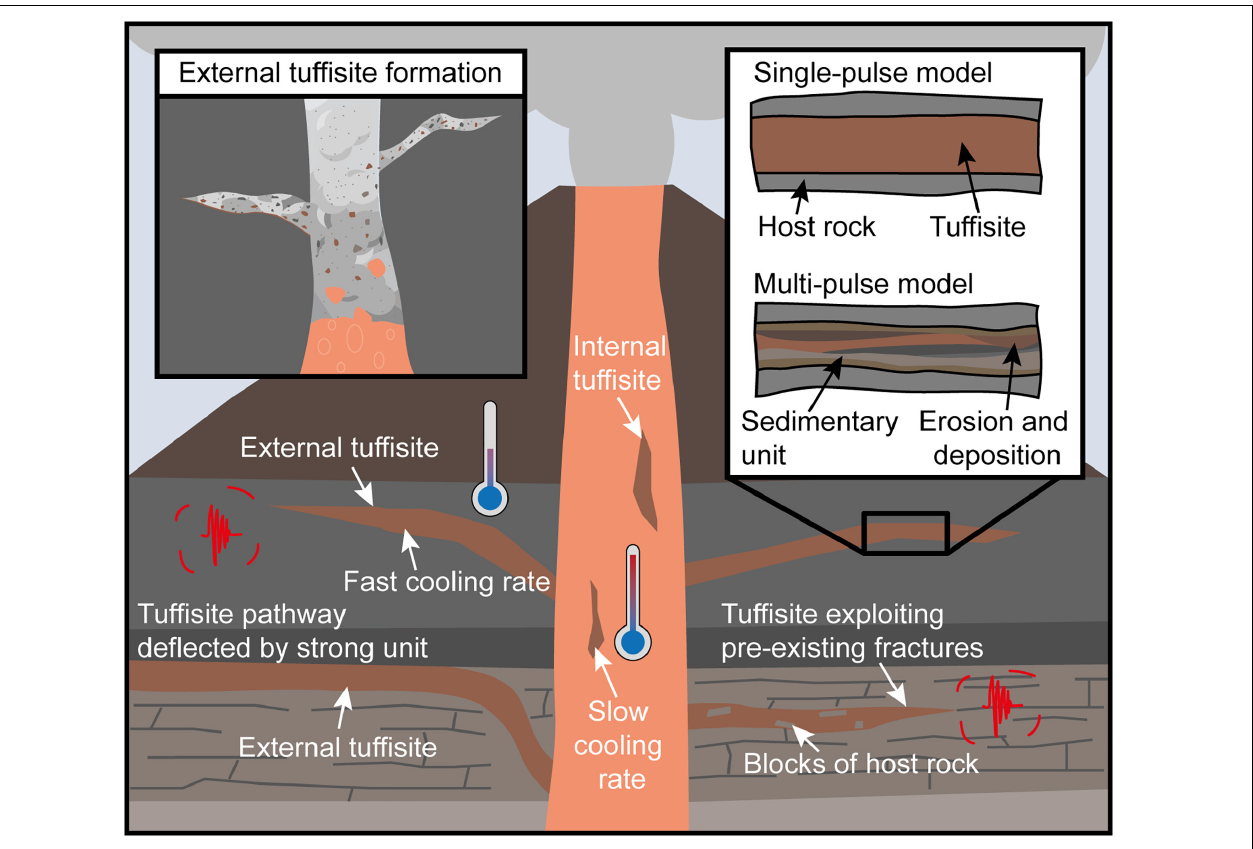
FIGURE 1 | Schematic showing the position of internal and external tuffisites with relation to the volcanic conduit. Internal tuffisites form within volcanic conduits, propagating through hot magma itself. External tuffisites form in the country rock surrounding the conduit when the fluid pressure exceeds the strength of the country rock. The morphology of external tuffisites, like magmatic dykes and sills, is influenced by the characteristics of the host rock. Tuffisites can be guided by pre-existing fractures, exploiting the easiest pathway for propagation. Strong units may act as barriers to fracture propagation, deflecting or temporarily stalling a propagating fracture. External tuffisites will cool more rapidly than internal tuffisites, as they are injected into the cold country rock. Tuffisites formed by only one pulse of material will have a simple internal structure, typically with fine-grained margins grading into a coarser-grained centre. Tuffisites formed by multiple pulses have a more complex structure, with multiple sedimentary units that may have erosive